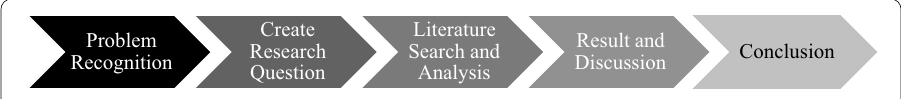
Fig. 3 The process of conducting a structural literature